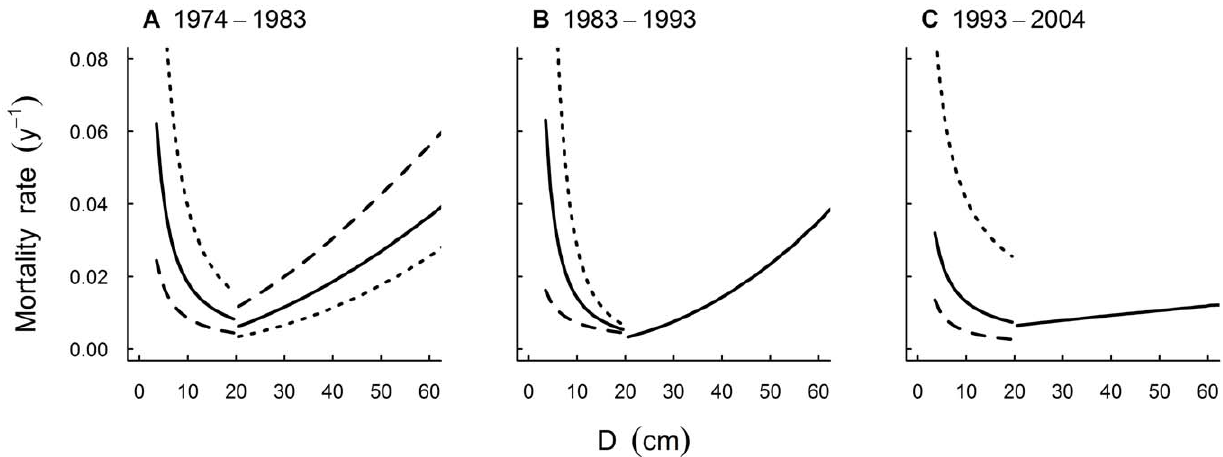
Figure 3. Temporal variation in size-specific mortality patterns. Size-specific mortality patterns for the three census periods, ( A ) 1974–1983, ( B ) 1983–1993 and ( C ) 1993–2004; based on separate analyses for small (D , 20 cm) and large (D $ 20 cm) trees. Solid lines show the significant modelled relationships between mortality and D determined from a simulation drawing on the posterior distribution of parameter estimates. For small trees ( A – C ), and large trees ( A ), the dashed and dotted lines show the significant relationships with neighbourhood crowding (i.e. basal area of larger neighbours (BAL) for small trees, basal area of all neighbours (BA) for large trees), representing low (dashed) and high (dotted) neighbourhood crowding (the 5% and 95% quantiles of BAL/BA for small and large trees)